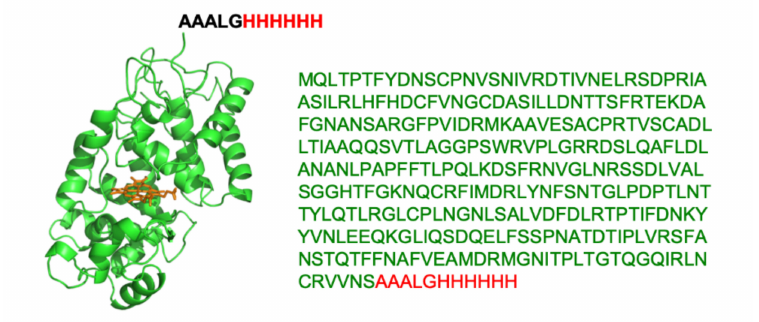
Figure 2. Structure and amino acid sequence of His-tagged